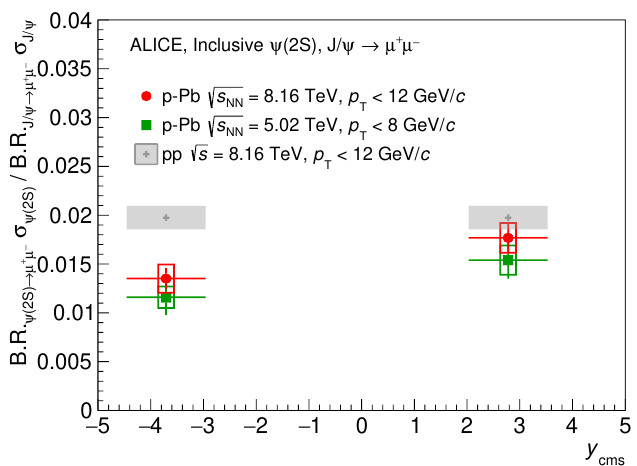
Figure 4 . The ratio B : R : (cid:27) (2S) = B : R : (cid:27) J = as a function of y cms for p-Pb (2S) ! (cid:22) + (cid:22) (cid:0) J = ! (cid:22) + (cid:22) (cid:0) p collisions at s NN = 8 : 16 TeV, compared with the corresponding pp quantity, shown as a grey p band and obtained via an interpolation of results at s = 5, 7, 8 and 13 TeV [51]. The error bars represent the statistical uncertainties, while the boxes correspond to uncorrelated systematic p uncertainties. The published p-Pb results at s NN = 5 : 02 TeV [31] are also shown.